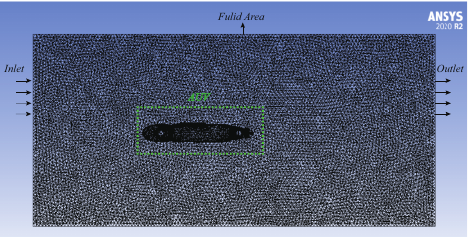
Figure 3. Mesh result.